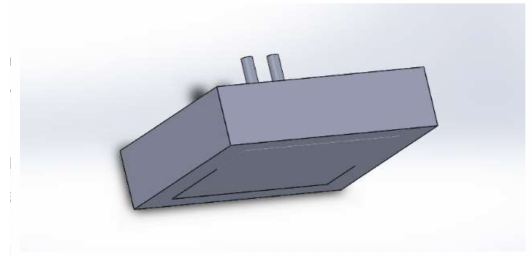
Figure 4. Schematic of the geometry shape of the twin jets on a heated